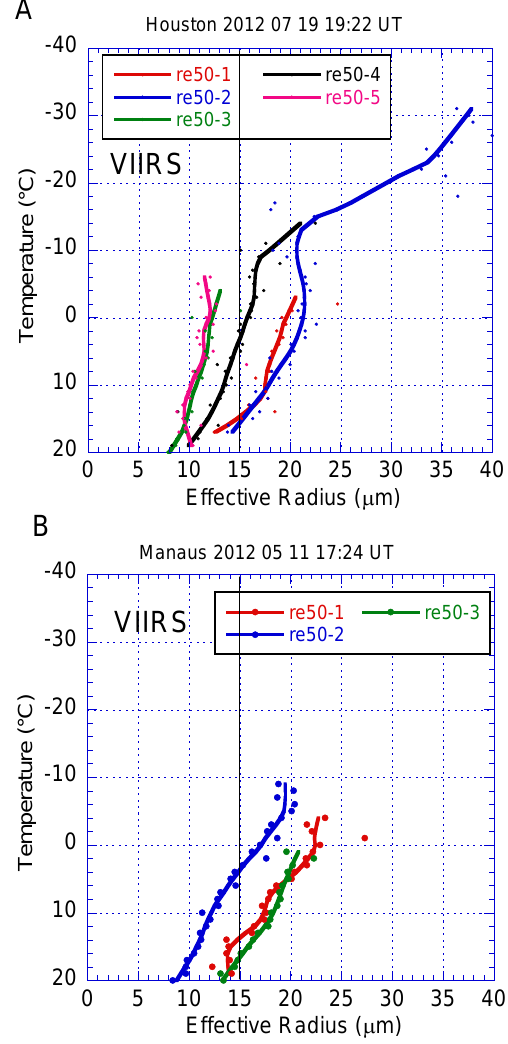
Fig. 17. Same as Fig. 5, but for the contrasting conditions between the polluted clouds. Panel (A) : urban polluted clouds with reduced r e over Houston, Texas (lines 3 and 5), compared with background clouds to the west and NW of the city (lines 1 and 2), represent the areas shown in Fig. 15. Panel (B) : the T – r e of the clouds pollution plume of Manaus in the Amazon is shown by line 2, whereas lines 1 and 3 show the background pristine clouds that represent the areas shown in Fig.